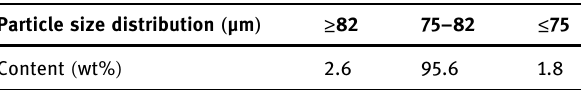
Table 1: The particle size distribution of the converter precipitator dust